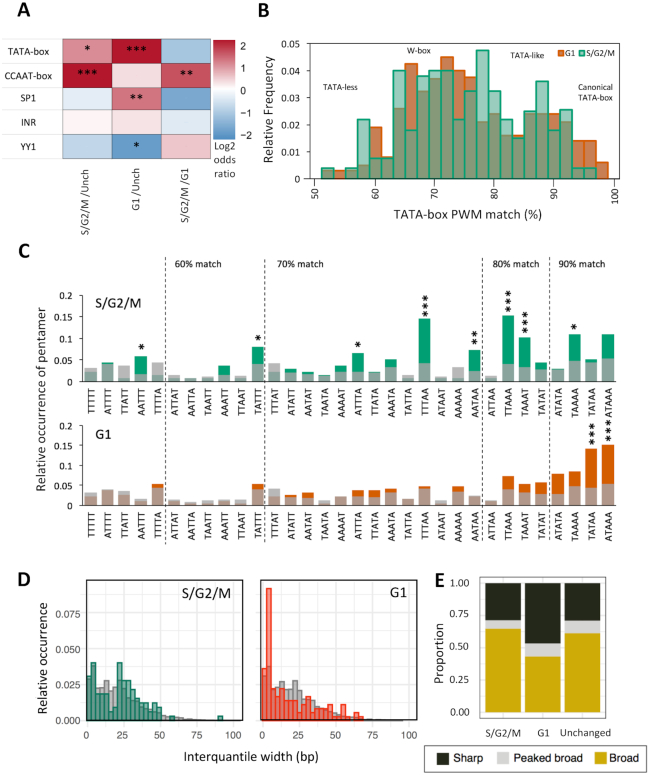
Core promoter architecture. (A) Heatmap visualizing the log2 odds ratio of occurrence of core promoter motifs between genes upregulated in G1 and S/G2/M and unchanged (*P< 0.05, **P< 0.01, ***P< 0.001, Fisher's exact test). (B) Distribution of position weight matrix (PWM) match (%) to TATA-box in the region –40 to –20 bp upstream of the dominant TSS in genes upregulated in S/G2/M and G1 populations. (C) A/T pentamer relative occurrence 20 to 40 bp upstream of TSS of genes upregulated in S/G2/M (green), G1 (red) and unchanged expression (grey). Ordering of pentamers is by best-fit match to the TATA PWM incremental thresholds shown. Pentamers significantly enriched in each group relative to pentamer occurrence in genes with unchanged expression (*P< 0.05, **P< 0.01, ***P< 0.001, Fisher's exact test). (D) Consensus cluster interquantile width in genes upregulated in S/G2/M (green) and G1 (red) and with unchanged expression (grey) visualized as a histogram. (E) Promoter shape distribution per group. Classifications; sharp (at least 90% of the expression from the promoter emanating from TSSs within 10bp of one another (IQW < 10) and ≥60% of expression emanating from a single dominant TSS); Sharp with broad background (≥60% of expression emanating from a single dominant TSS, but IQW ≥ 10) and Broad (<60% of expression emanating from a single dominant TSS and IQW ≥ 10).